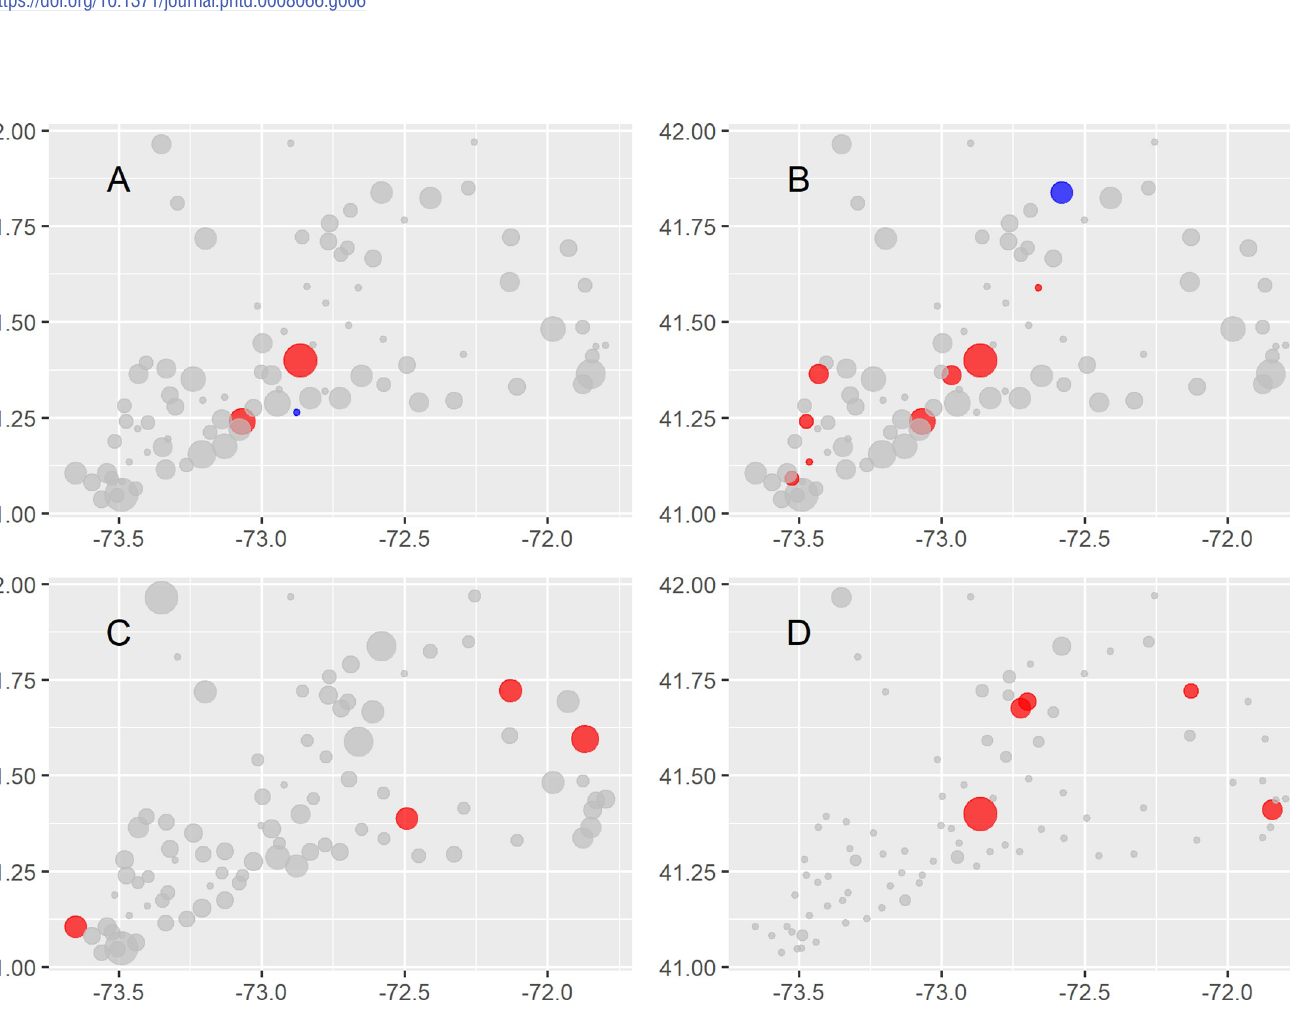
Fig 7. Risk maps for the mammalian arboviruses: Cache Valley virus (A), Jamestown Canyon virus (B), Potosi virus (C), Trivittatus virus (D). Point sizes correspond to the number of isolates scaled to the maximum number of isolates detected while colors indicate whether the 95% confidence interval for the odds of arbovirus detection were > 1 (red), included 1 (grey), or were < 1